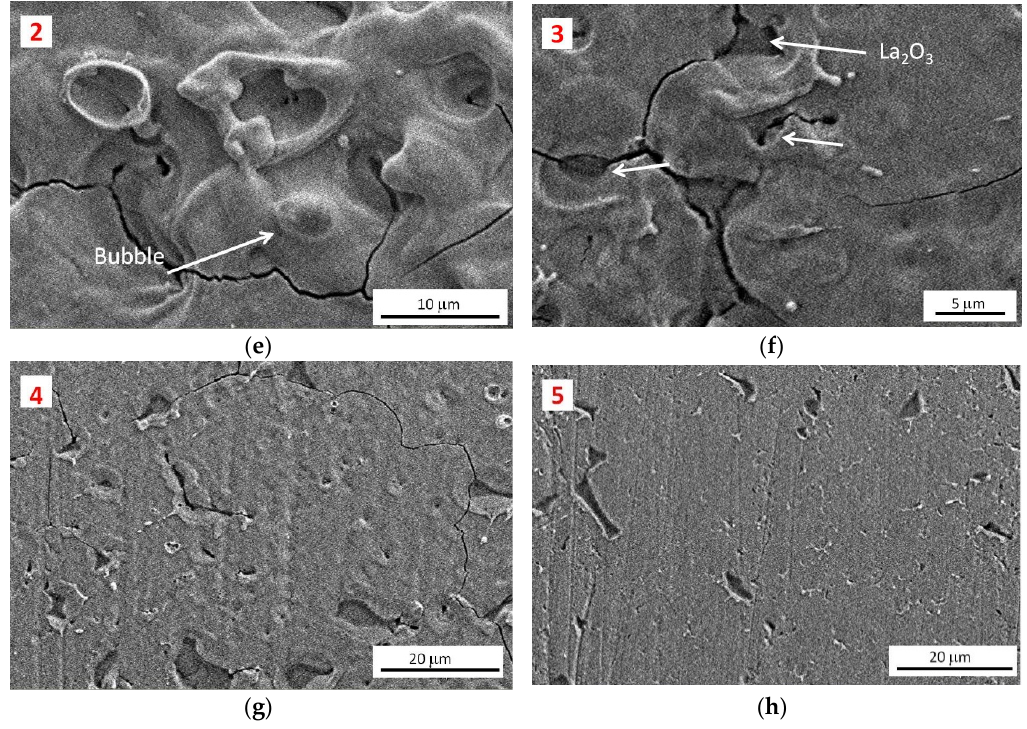
Figure 6. W-1% La 2 O 3 : SEM micrographs showing different zones of the area affected by laser pulse. The numbers in each micrograph correspond to the zones indicated in ( a ): the depression ( b – c ), the ridge around the depression ( d – e ), the outer zone ( f ), the border between affected and unaffected zones ( g ) and the unaffected zone ( h ).